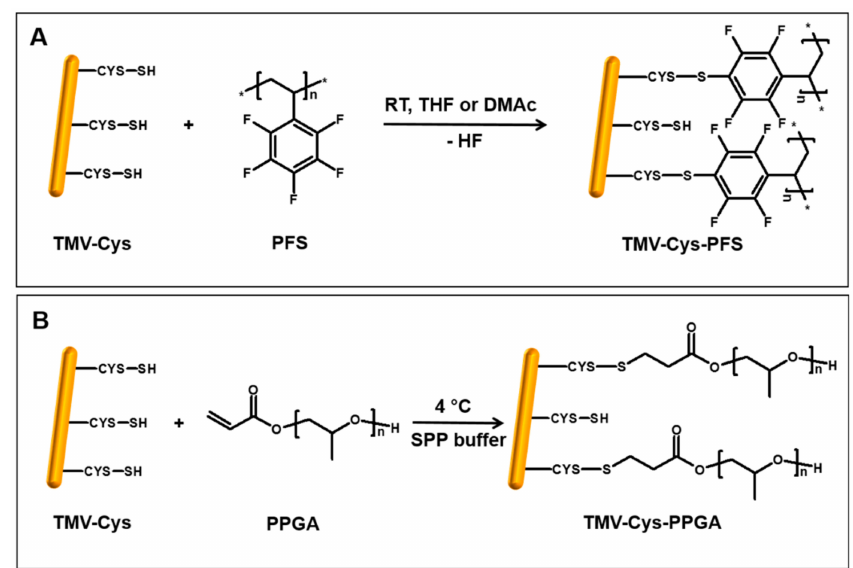
Scheme 2. Click reaction of TMV-Cys mutant with poly(pentafluorostyrene) (PFS) and poly(propylene glycol) acrylate (PPGA).